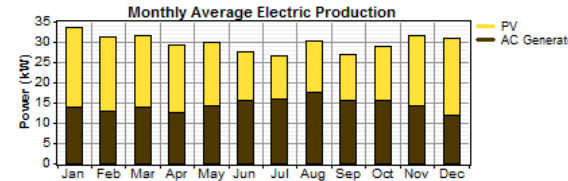
and therefore results in low electrical output of the PV gen- erator. The months of February, March, April, May and De- cember fall into the peak of dry season with higher sun- shine hour, higher clearness index and higher global solar radiation. Consequently, the hour of runs of diesel gener- ator is reduced during these